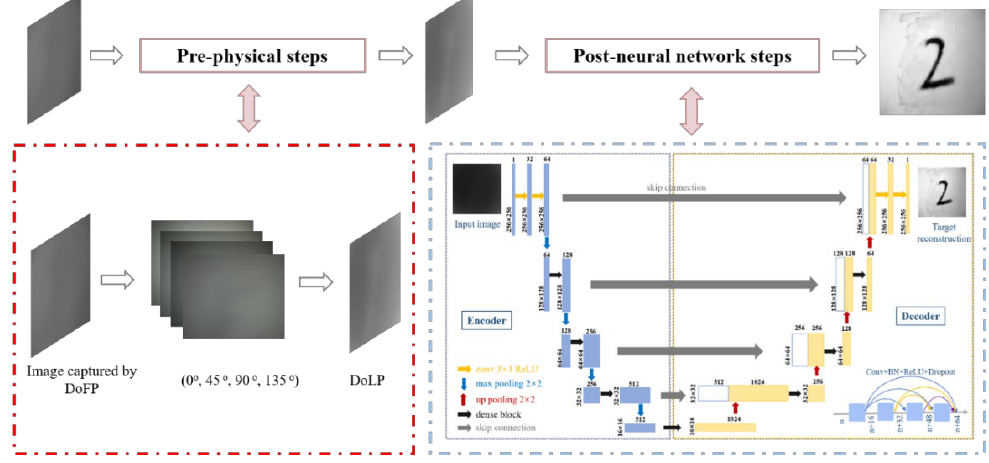
Figure 1. Learning framework.